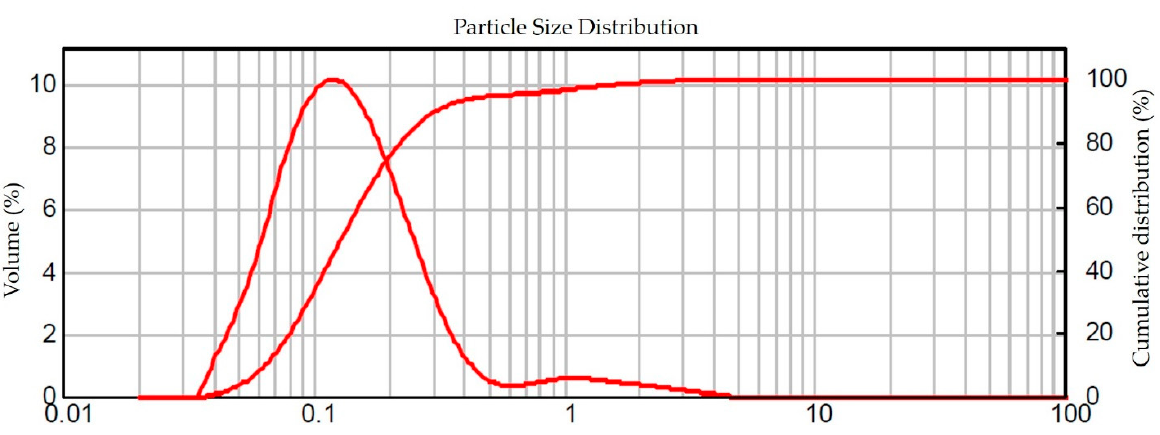
Figure 4. Particle size distribution of besifloxacin nanosuspension 0.6 wt% by laser diffraction (LD). Representative of three runs ( n = 3).